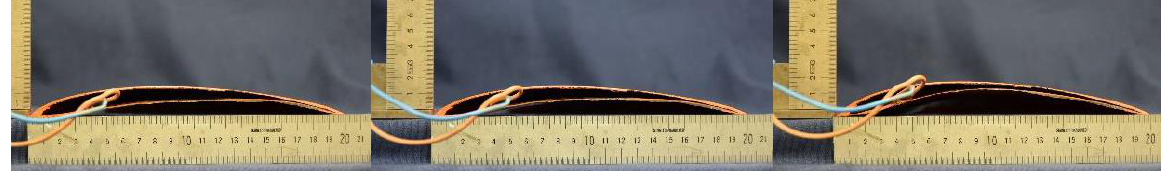
Figure 3. Eppler 61 airfoil with 0 V ( left ), applied voltage of 2.8 V ( center ) and 5 V ( right ). Ref. [10].